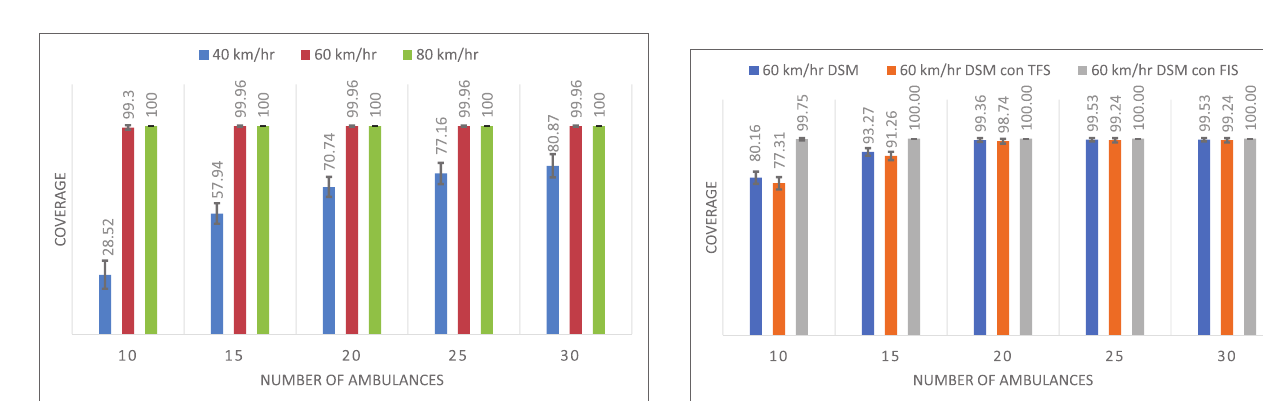
FigUre 10 | Comparison of coverage (mean and SD) with a speed of 60 km/h.